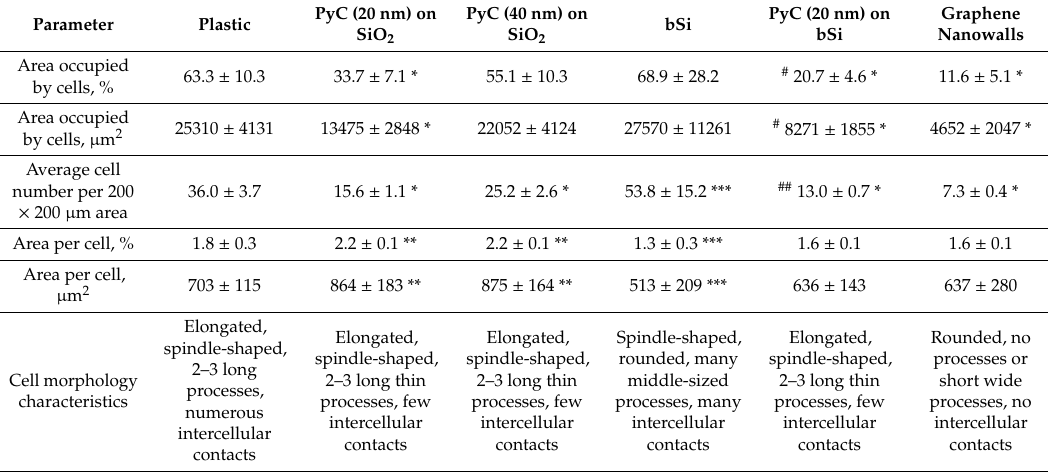
Figure 4. Typical fluorescent images of glioma cells grown on substrates with different roughnesses. Glioma cells were grown on ( a ) plastic (as a control); ( b ) bSi; ( c ) PyC (20 nm) on bSi; ( d ) PyC (20 nm) on SiO 2 ; ( e ) PyC (40 nm) on SiO 2 ; ( f ) graphene nanowalls. Long processes are marked with arrows. Cells were stained with propidium iodide. Image size 115 × 115 µm. Table 3. Cell confluence and morphological features of cells grown onto different substrates.